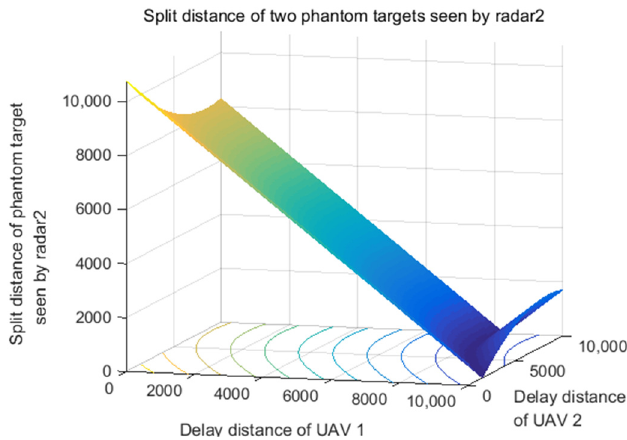
Figure 9. Split distance of two phantom targets seen by radar 2.